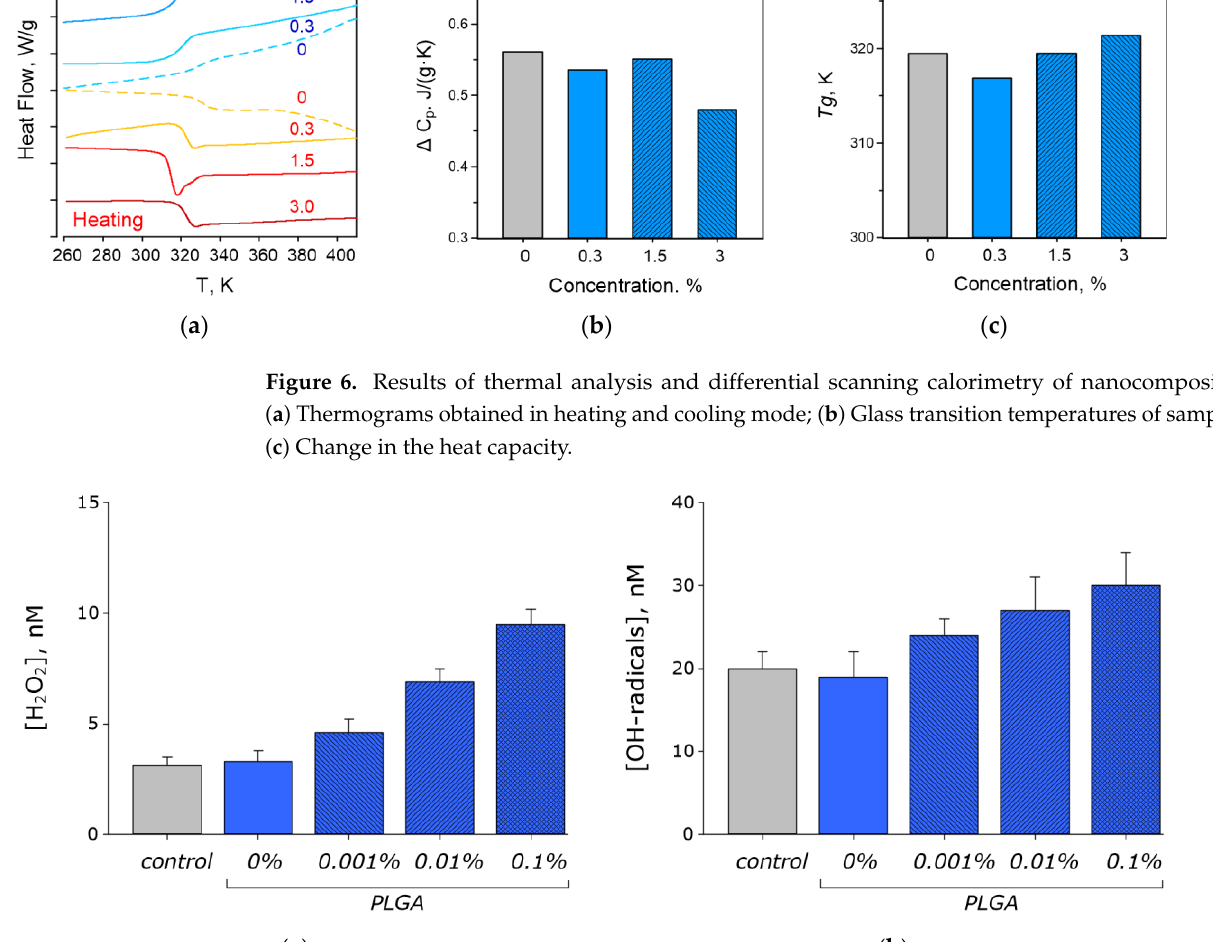
Figure 8. Effect of composite material containing PLGA and Al 2 O 3 NPs on the biomacromolecules damage formation: ( a ) Generation of 8-oxo-Gua in DNA in vitro (2 h, 45 °C); ( b ) Generation and dynamics of decomposition of LRPS (2 h, 40 °C); Data are presented as mean values and standard errors of mean. The influence of the nanocomposite on the generation of 8-oxo-Gua and LRPS was studied (Figure 8). PLGA without dopant did not affect the generation of 8-oxo-Gua in DNA (Figure 8a). The addition of Al 2 O 3 NPs increased the generation of 8-oxo-Gua in DNA (compared to PLGA without dopant) by 28, 64 and 92% at NP concentrations of 0.001, 0.01 and 0.1%, respectively. PLGA without dopant increased LRPS generation by 14% compared to control (Figure 8b). This effect was found only in the first hour after the experiment. After 3 – 5 h, no differences were found between the concentrations of LRPS in control and PLGA without dopant. The addition of Al 2 O 3 NPs increased the generation